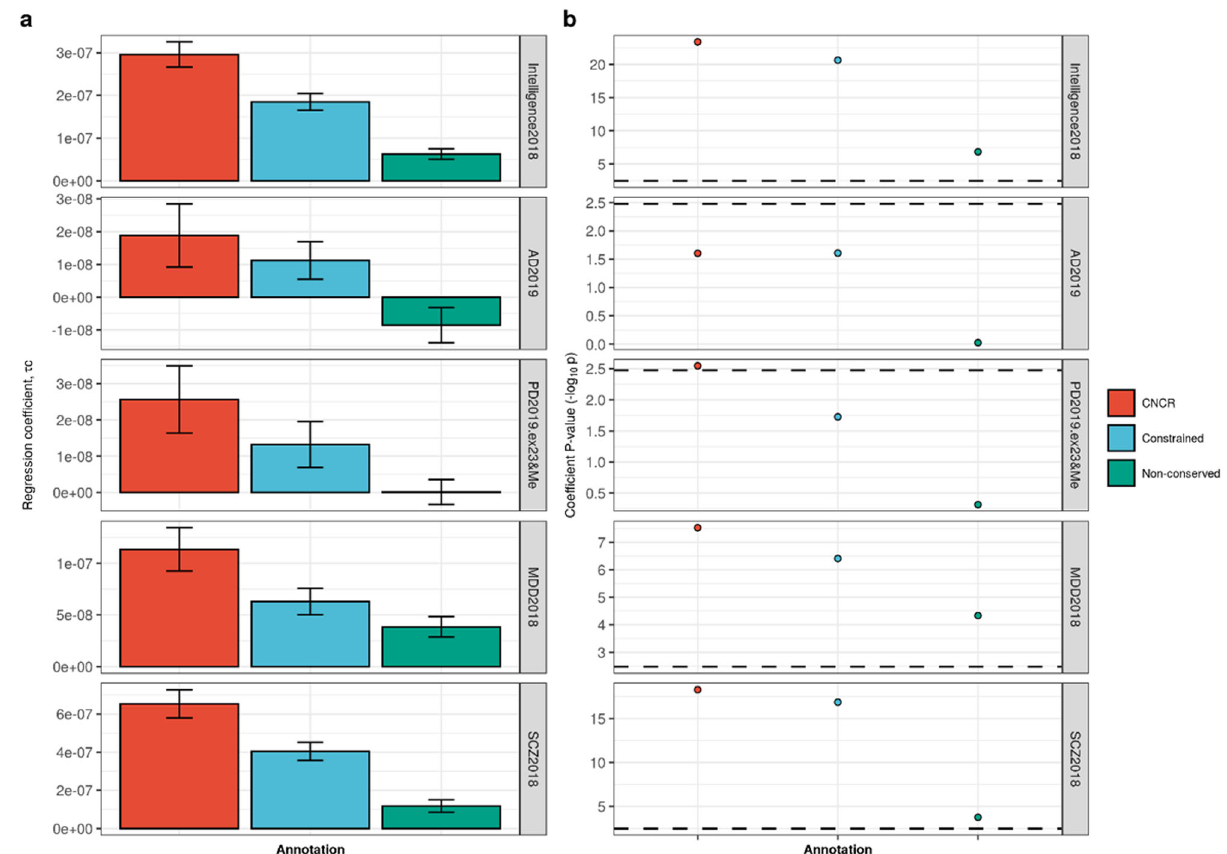
Fig. 3 Strati fi ed-linkage disequilibrium score regression (s-LDSC) analysis across fi ve traits comparing constrained, non-conserved regions (CNCRs) with its constituent constrained and non-conserved annotations. a The regression coef fi cient. b The regression coef fi cient − log 10 ( p value) with the dotted line showing the Bonferroni-corrected p value of 0.00333 for 15 conditions. GWASs were as follows: Intelligence2019: intelligence test performance GWAS, AD2018: Alzheimer ’ s disease GWAS, PD2019.ex23&Me: Parkinson ’ s disease GWAS without 23&Me data, MDD2018: major depressive disorders GWAS and SCZ2018: schizophrenia GWAS (Supplementary Table 2).